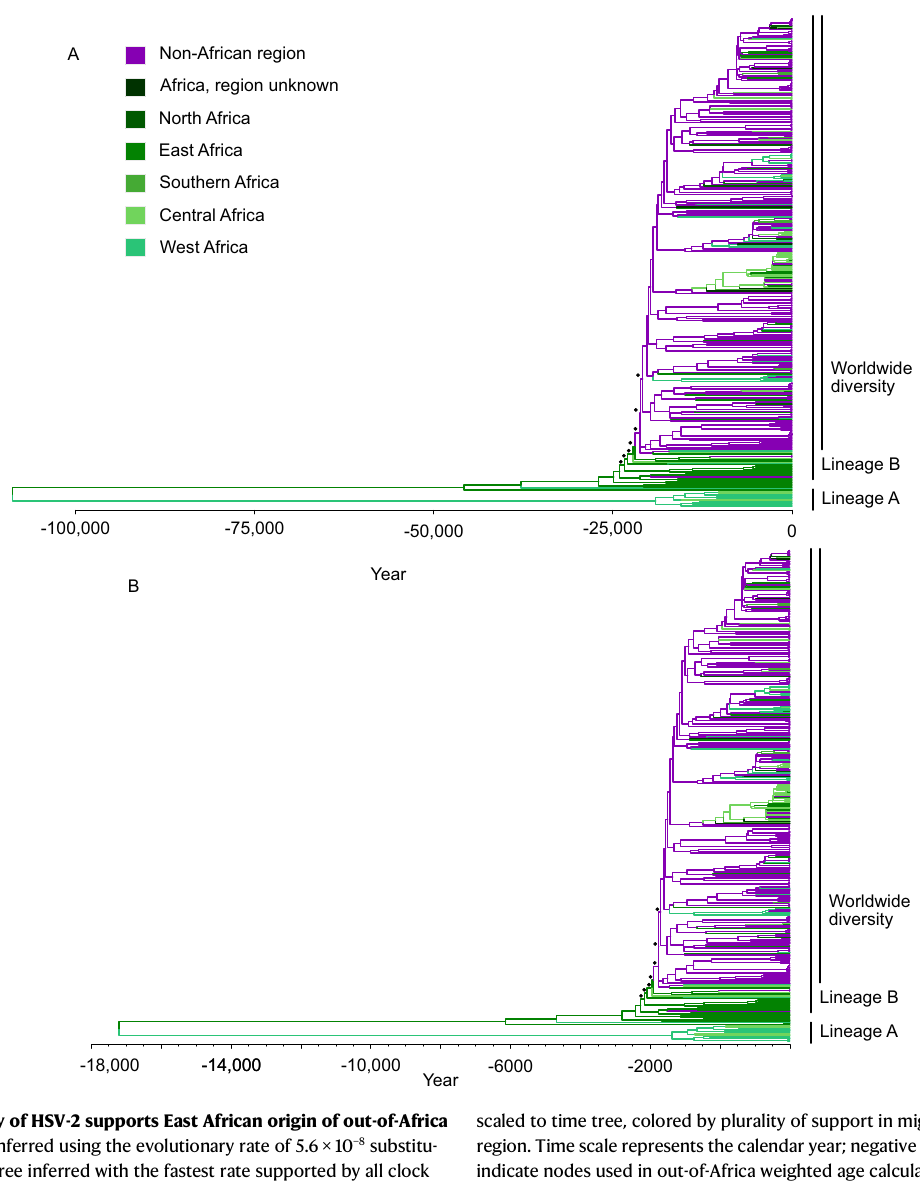
scaled to time tree, colored by plurality of support in migration analysis for each region. Time scale represents the calendar year; negativeyears are BCE. Black dots indicate nodes used in out-of-Africa weighted age calculation (see Supplemen- tary Fig. 1).